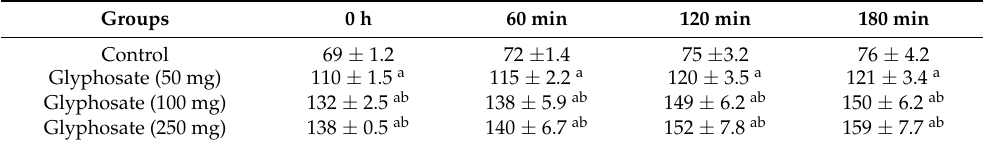
Table 2. OGT in glyphosate exposed diabetic animals.